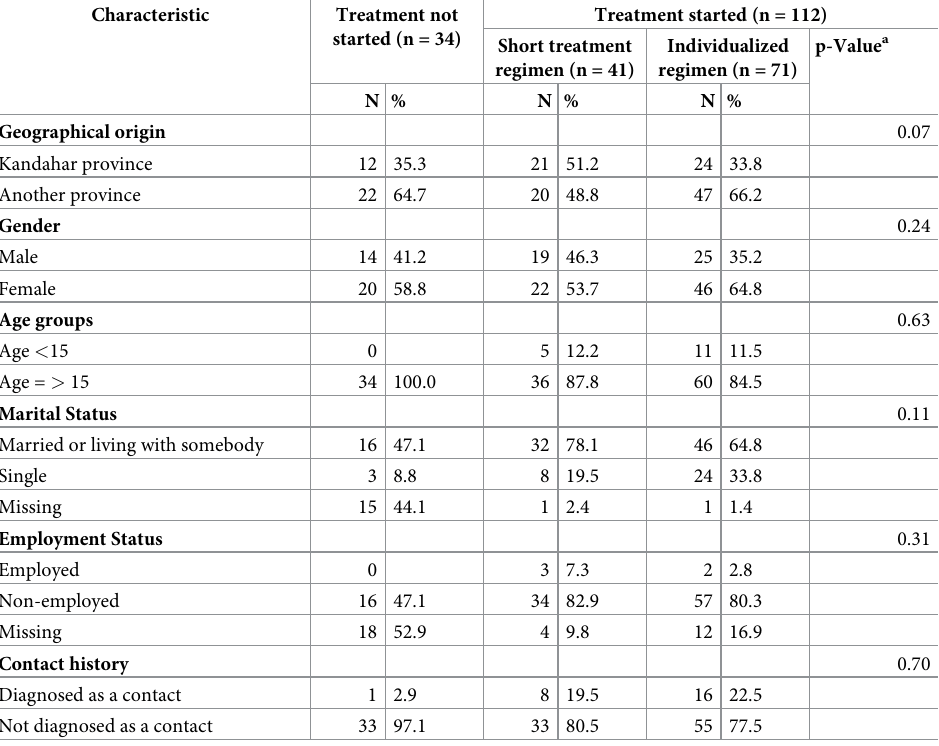
Table 1. Demographic characteristics of patients enrolled in RR-TB care, by treatment.